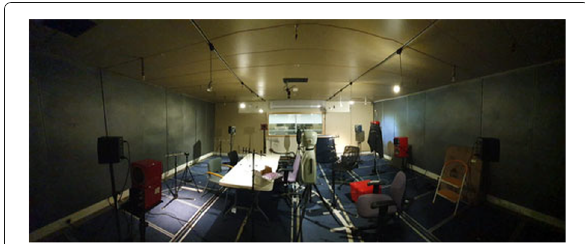
Table 3 Measurement and recording